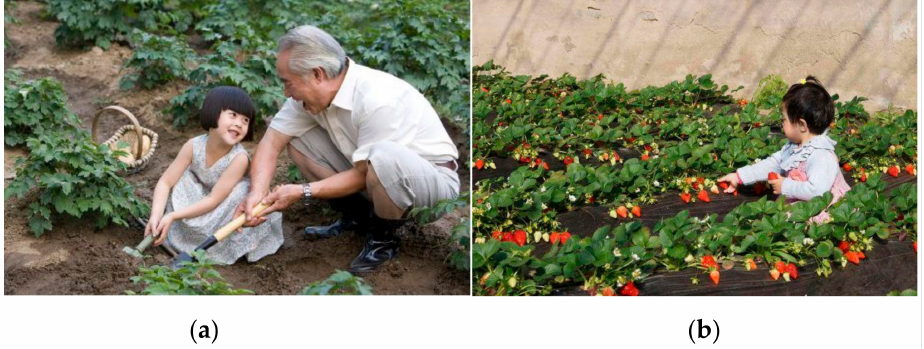
Figure 1. Typical sightseeing picking orchards in China: ( a ) potato farm; ( b ) strawberry farm. (These photos were acquired from the publicity website of two eco-farms. The websites are https://sh. news.fang.com/open/33125923.html and http://www.lvmama.com/comment/2434478, accessed on 22 April